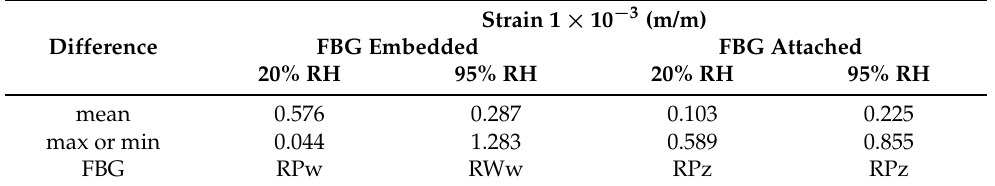
Table 10. Comparison of the strain curves for both materials after exposition on elevated